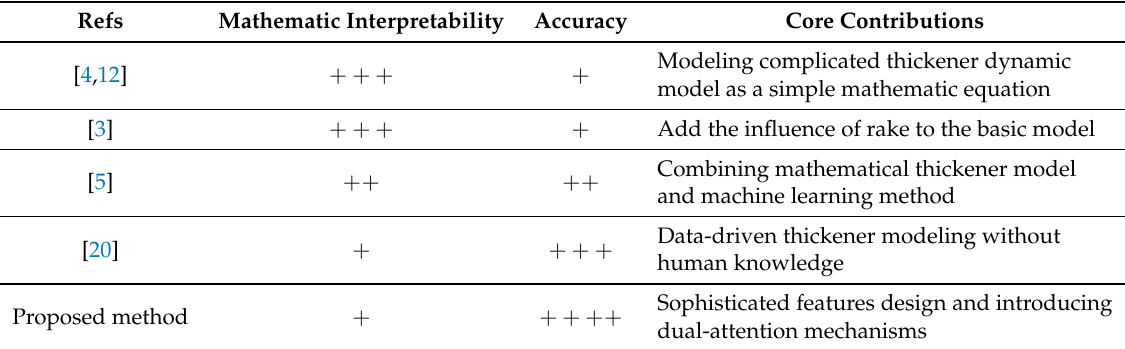
Table 1. Summarizing of features and contributions of some references.